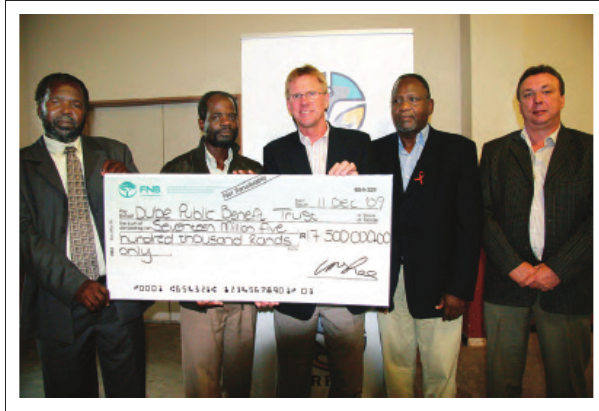
FIGURE 2: The Dube community representatives receiving a once-off endowment of R17.5 million from Richards Bay